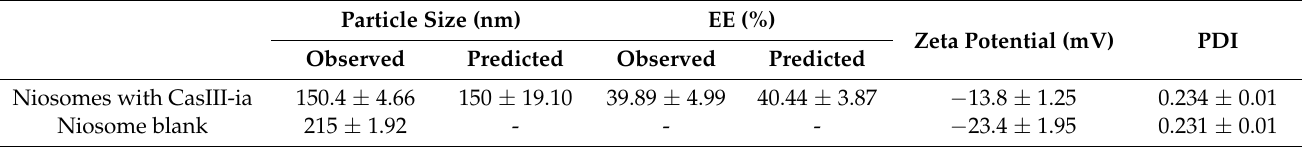
Table 4. Particle size, EE, zeta potential, and PDI niosome with and without optimized CasIII-ia ( n =